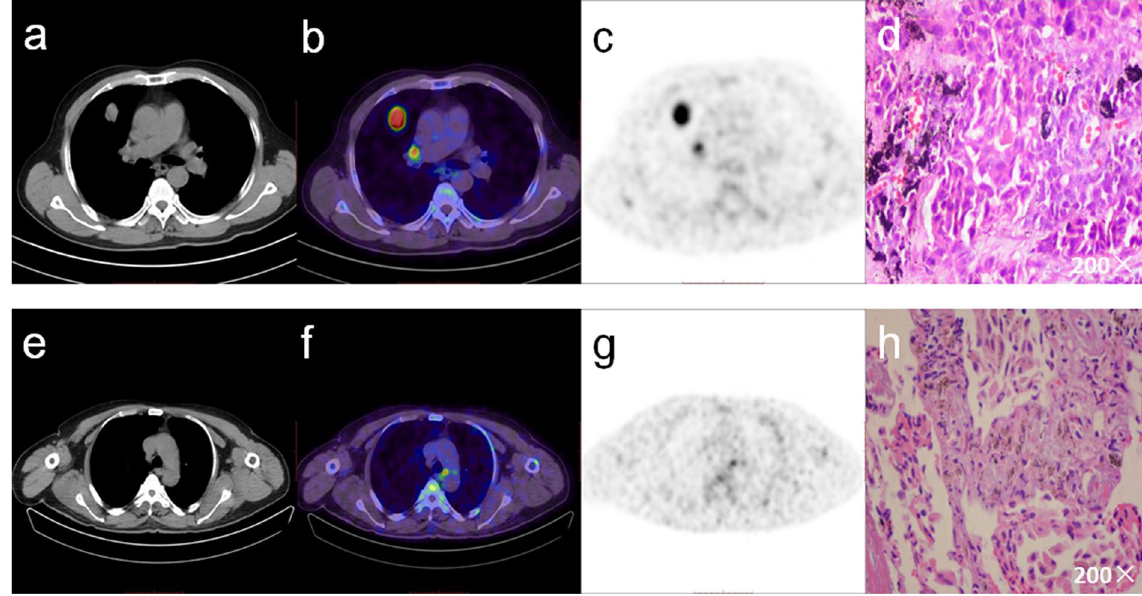
Figure 2. The upper row shows a 62-year-old male suffering from an adenocarcinoma of the upper right lobe. LN station 10 according to Mountain and Dresler 1 was classified as a true positive case ( a,b,c,d ). The lower row shows a 59-year-old male suffering from a squamous cell carcinoma of the lower left lobe. The increased focal 18 F-Alfatide uptake in PET/CT imaging is an example of false positive lymph node metastasis ( e,f,g,h ).